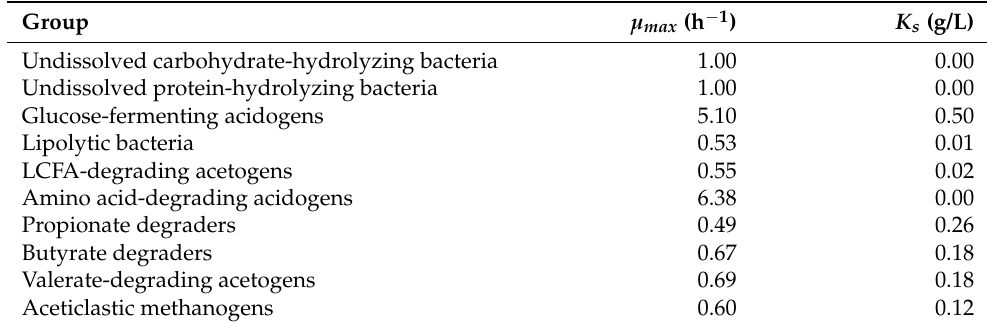
Table 1. Kinetic constants of the main microbial groups used for the simulation of the anaerobic digestion